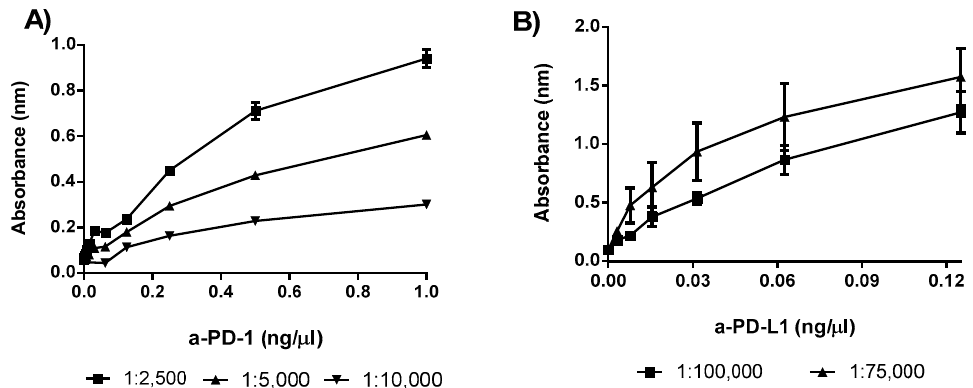
Figure 4. Di ff erent antibody dilutions performed to optimize the corresponding ELISA: ( A ) a-PD-1 assay with several a-Goat IgG HRP-conjugated dilutions; ( B ) a-PD-L1 assay with di ff erent concentrations of rat a-Goat IgG antibody. Data correspond to 3 independent experiments.